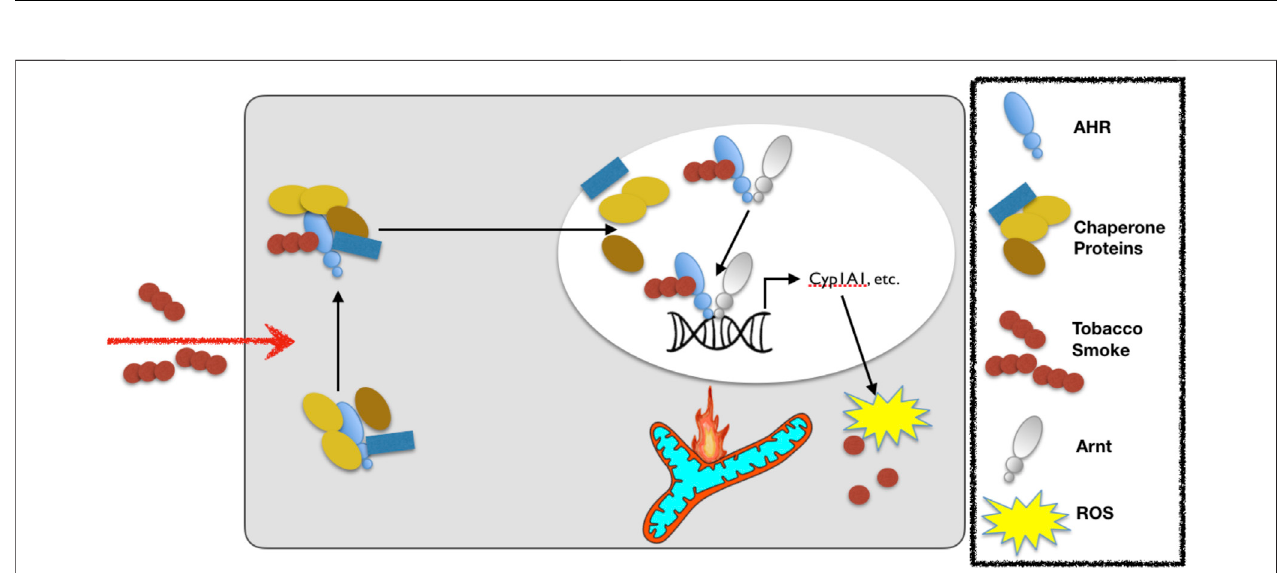
Frontiers in Physiology |